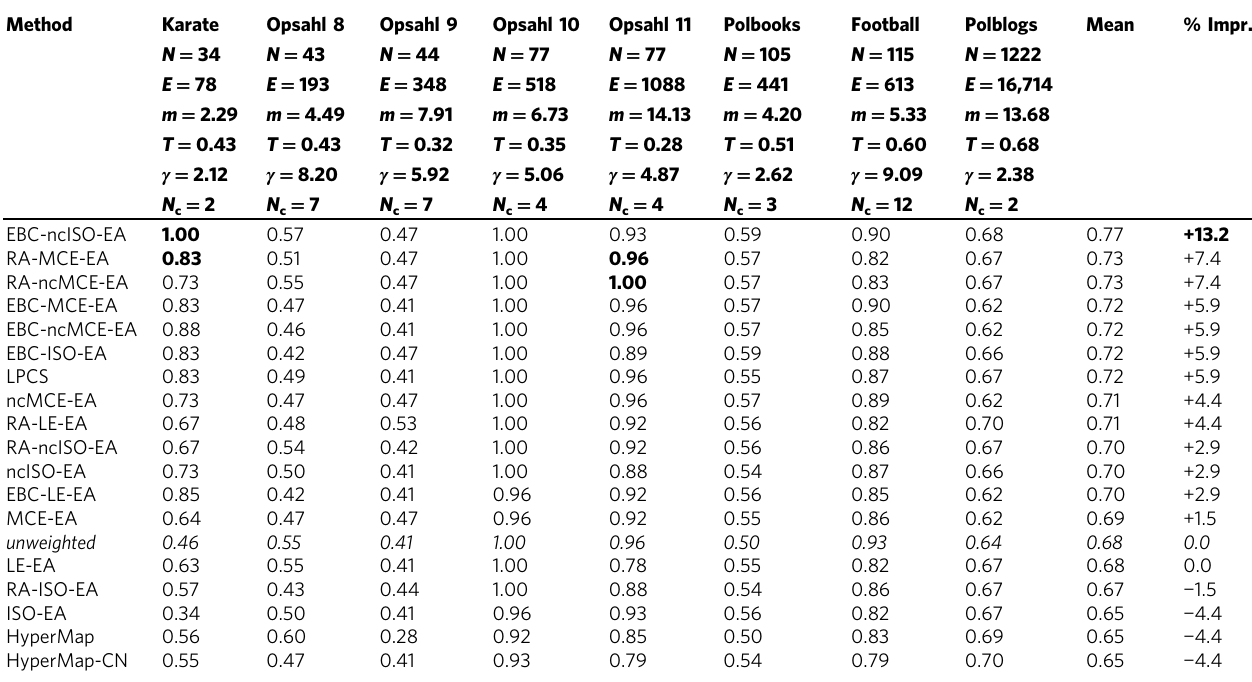
Normalized mutual information (NMI) computed between the ground truth communities and the ones detected by the Louvain algorithm for eight real networks. NMI = 1 indicates a perfect match between the two partitions of the nodes. For each method, the network has been embedded in the hyperbolic space and the embedding coordinates are used to weight the input matrix for the Louvain algorithm: observed links are weighted using the hyperbolic distances between the nodes and non-observed links using the hyperbolic shortest paths (see “ Methods ” section for details). As a reference, theLouvainalgorithmhasbeenrungivingininputalsothe unweightedadjacency matrix,the relatedrowis highlightedinitalic.Thetablecontains alsosomestatisticsforeachnetwork: numberof nodes N , number of edges E , temperature T (inversely related to the clustering coef fi cient), power-law degree distribution exponent γ , half of average degree m , and number of ground truth communities N c . Due to the higher performance, only the EA methods are here reported, whereas the complete table is shown as Supplementary Table 1. The NMI values highlighted in bold for the Karate and Opsahl_11 networks are the ones whose embedding is shown in Fig. 7. The rightmost column reports the percentage of improvement with respect to the unweighted variant, the best result is highlighted in bold. The results obtained only weighting the observed links are shown in Supplementary Table